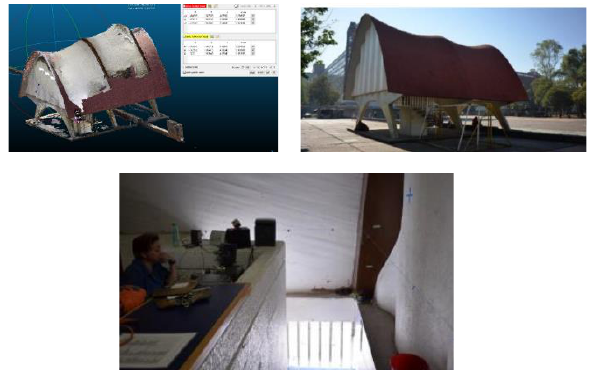
Figure 17. Left: Software not being able to merge the two point clouds properly – CloudCompare (Aligning, 2016). Right: Standing on the outside looking toward the railings which is the entrance to the pavilion. Bottom: Standing on the inside looking at the railings. (Pictures taken by Canadian students,